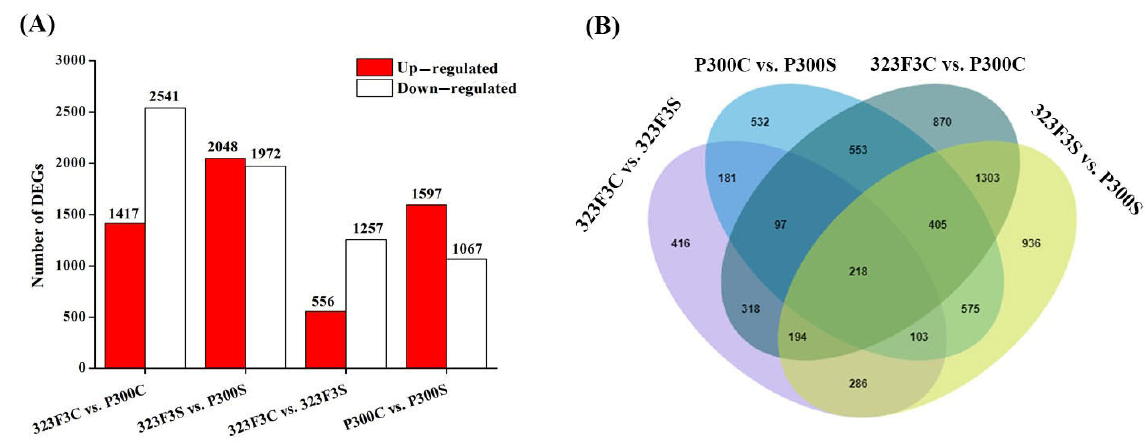
Figure 6. DEGs identified in the four comparisons among the control and salt treatment groups. ( A ) Total number of the up ‐ regulated and down ‐ regulated DEGs in the four comparisons. ( B ) Venn diagram of all DEGs in the four comparisons.